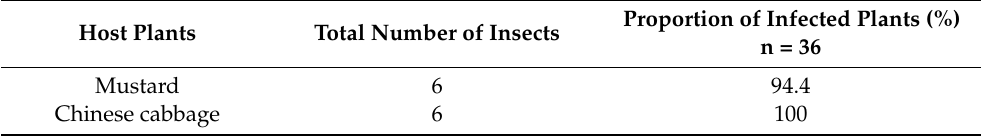
Table 5. BrYV transmitted to natural hosts-plants by